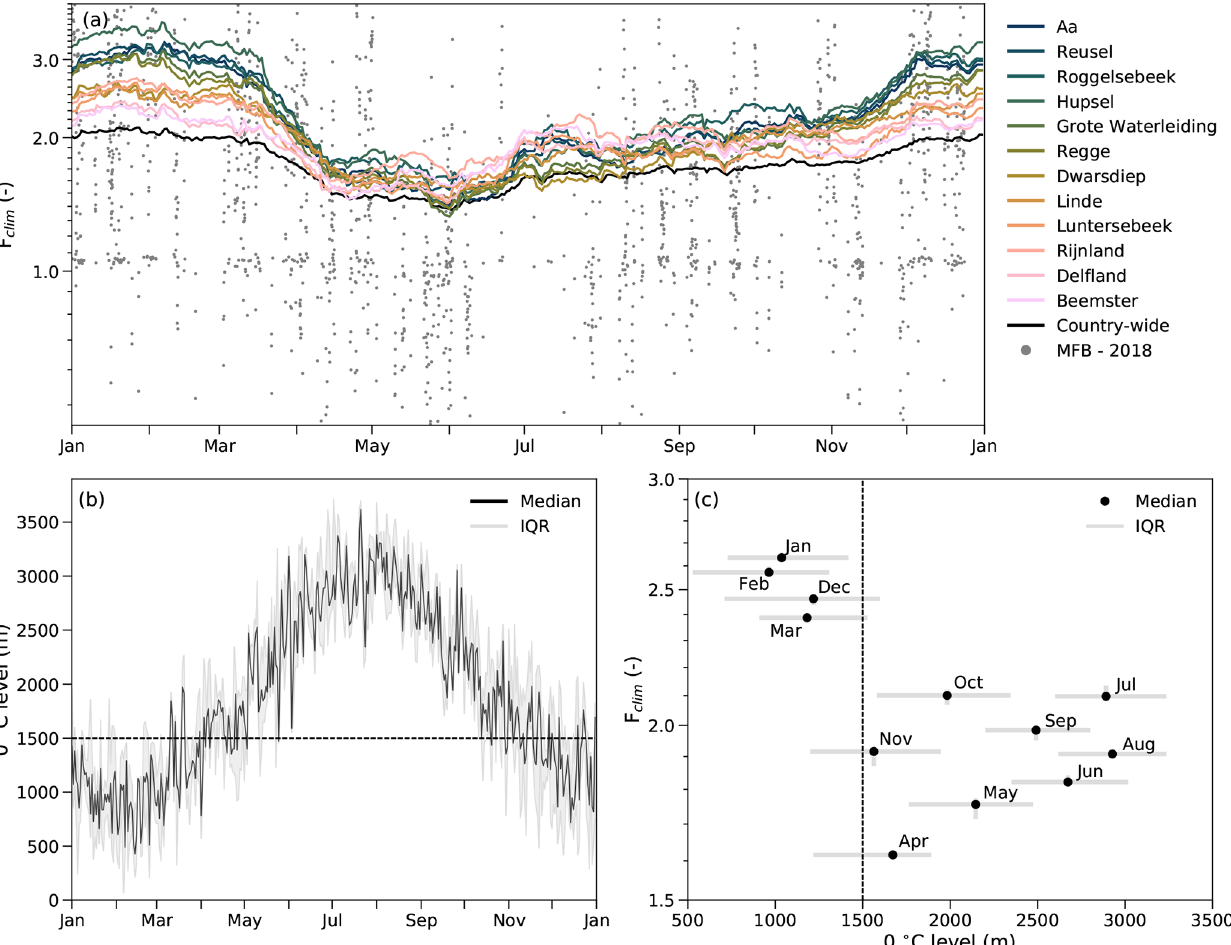
Figure 4. Seasonal dependency of the CARROTS factors and comparison with the operational MFB-adjustment factor. (a) Temporal vari- ability of the climatological daily adjustment factors for the 12 basins (colors, catchment-averaged), the country-average (black line) and of the country-wide hourly MFB factor for the (example) year 2018 (grey dots; some also fall outside the indicated range). (b) Estimate of the height of the 0 ◦ C isotherm at KNMI station De Bilt for all rainy hours in the 10-year period, based on a constant wet adiabatic lapse rate of 5.5Kkm − 1 . (c) Dependency of the monthly adjustment factor on the estimated 0 ◦ C isotherm level for KNMI station De Bilt and the superimposed grid cell of this station. Depending on the location in the radar composite, the minimum CARROTS factor can take place in a different month but is always between April and June. Note that for this analysis, the adjustment factor was based on only the rainfall sums within that month, the “effective adjustment factor” for that month, which roughly coincides with the factor for the 15th of the month in the CARROTS method. The grey bars indicate the interquartile range (IQR) for that month, based on the spread in hourly 0 ◦ C isotherm level estimates (the horizontal bars) and the sensitivity to leaving out individual years in the 10-year period for the factor derivation (vertical